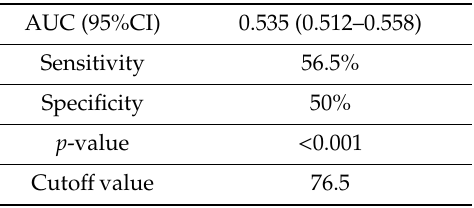
Table 5. Optimal cuto ff points of serum iron.